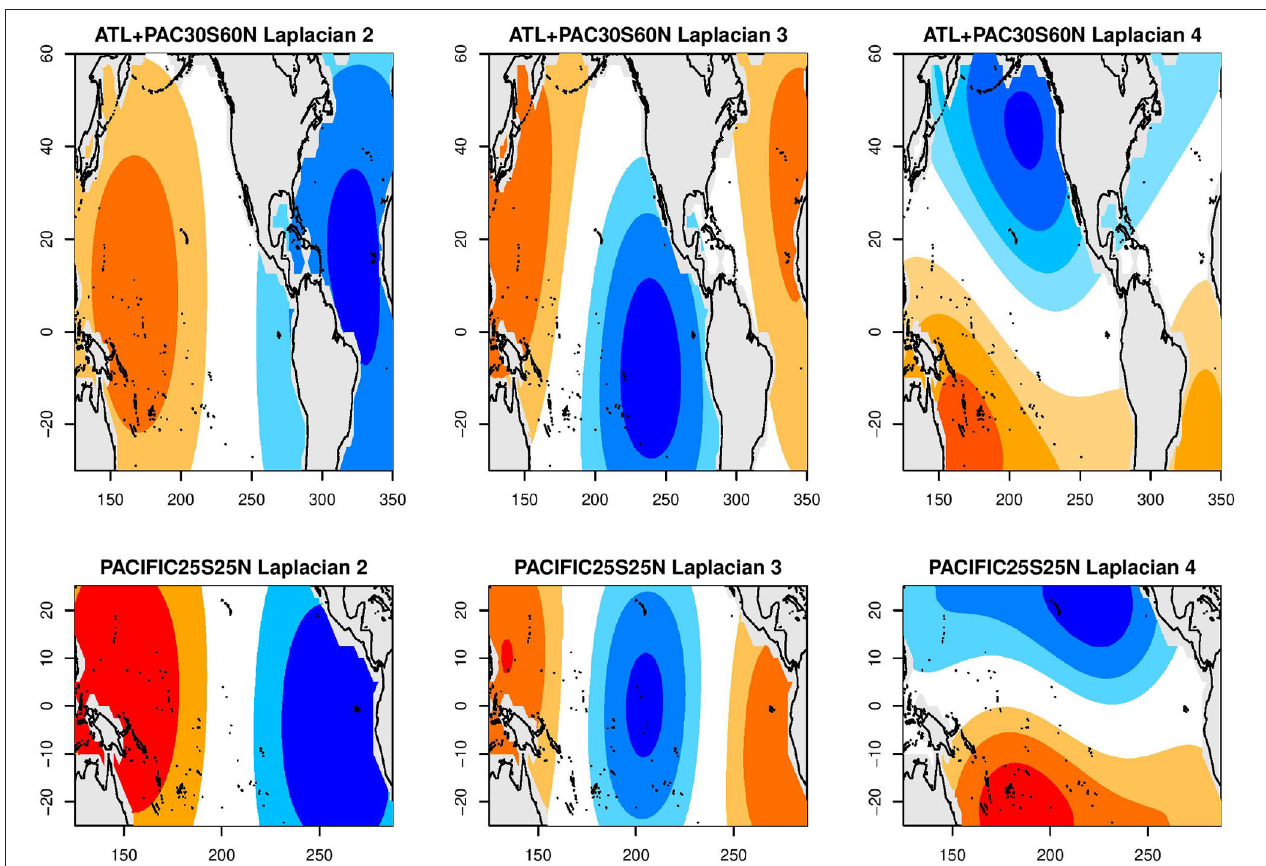
FIGURE 8 | Laplacian eigenvectors 2–4 for the Atlantic plus Pacific (top) , and for the tropical Pacific (bottom) domains. The first pattern for each basin is the spatial average over the domain and is not